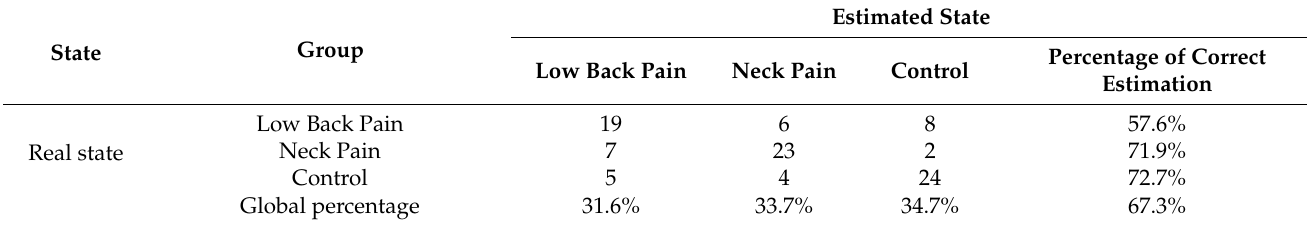
Table 2. Identification of clinical state according to multinomial regression